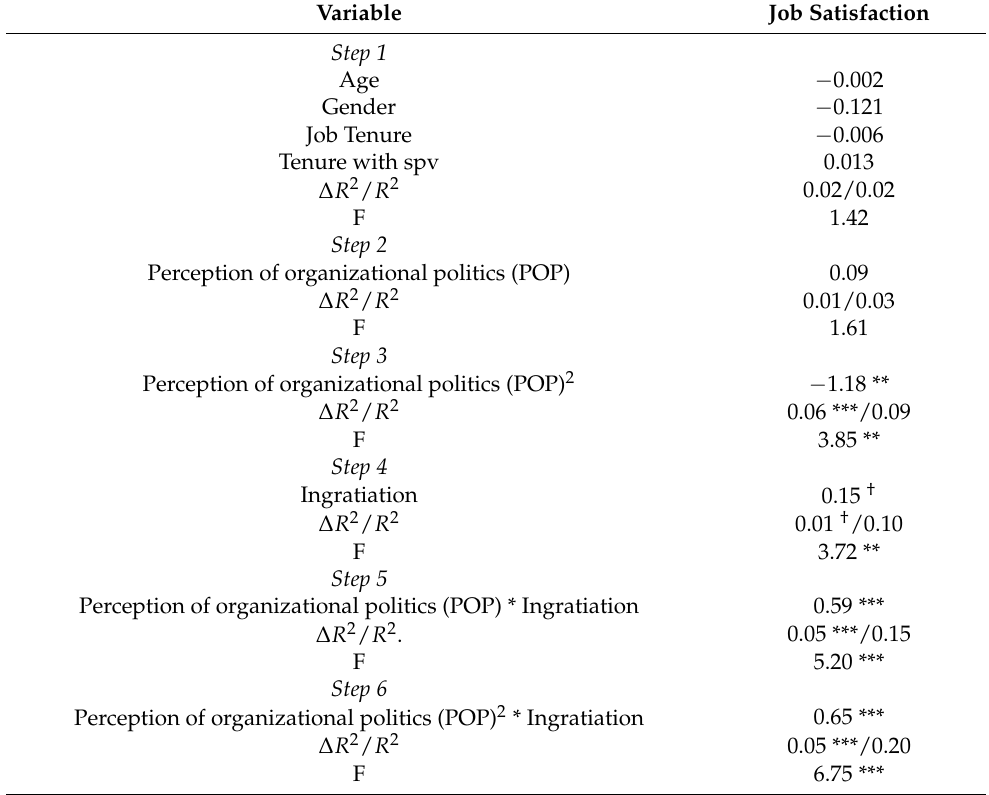
Table 2. Result of Polynomial Regression Analysis for Job Satisfaction of POP on